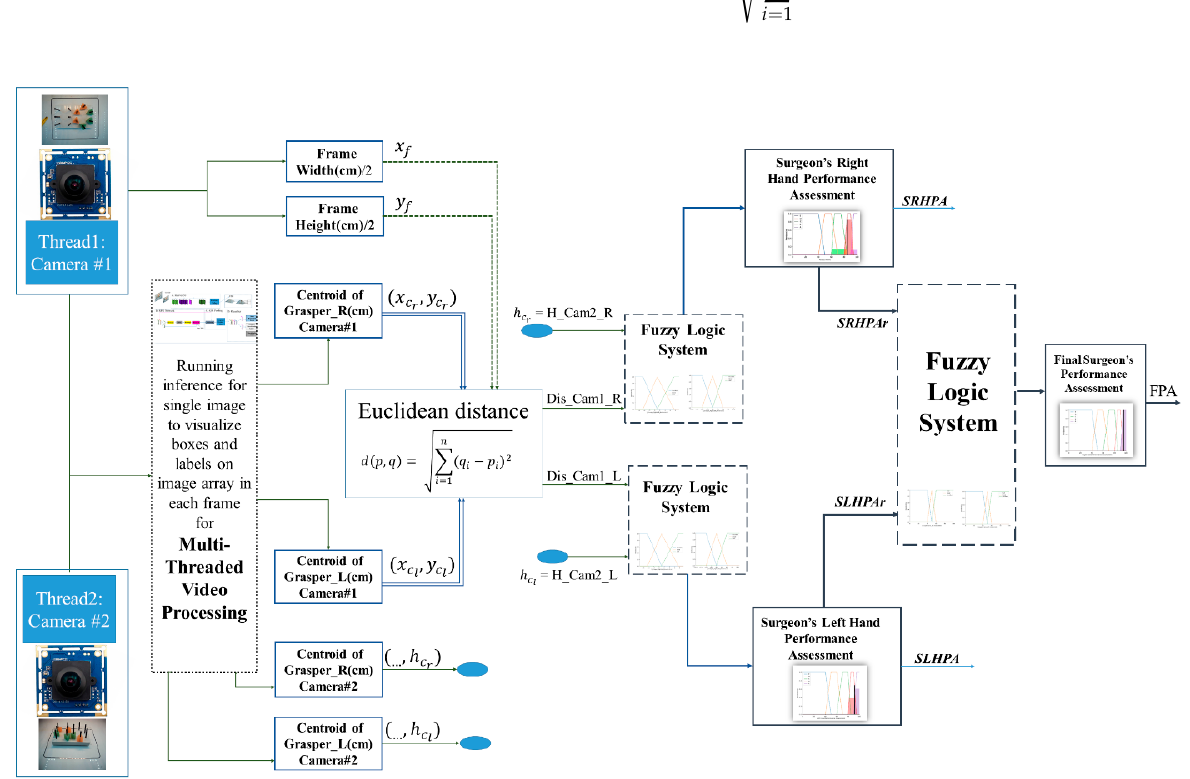
Figure 5. Block diagram of autonomous cascaded fuzzy supervisor assessment system in a multi- thread video processing experiment in the IBTS.